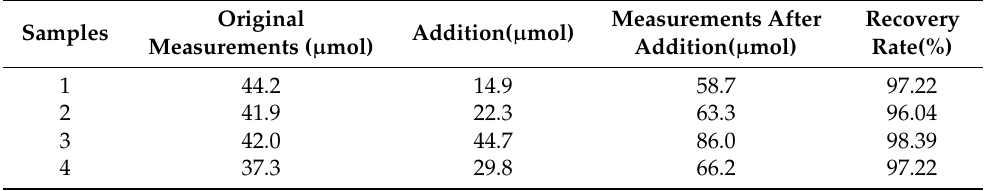
Table 2. Recovery rate of Cu 2+ .